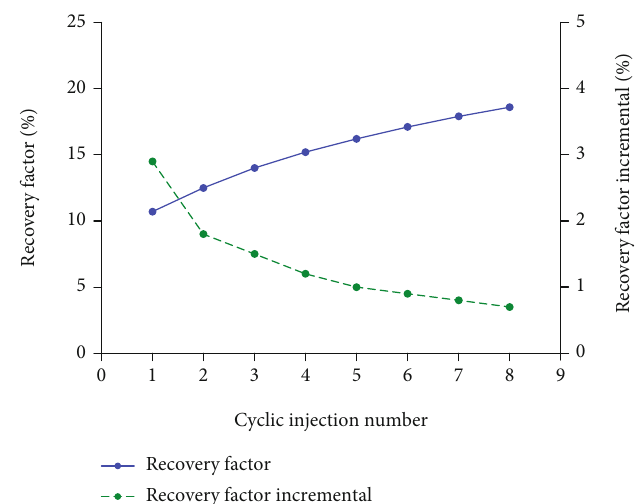
Figure 13: Recovery factors and recovery factor incremental with di ff erent cyclic surfactant injection